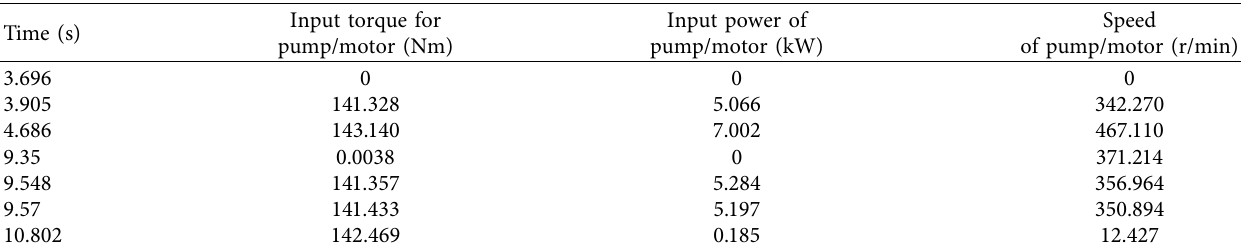
Table 12: Variations in torque and power in energy recovery